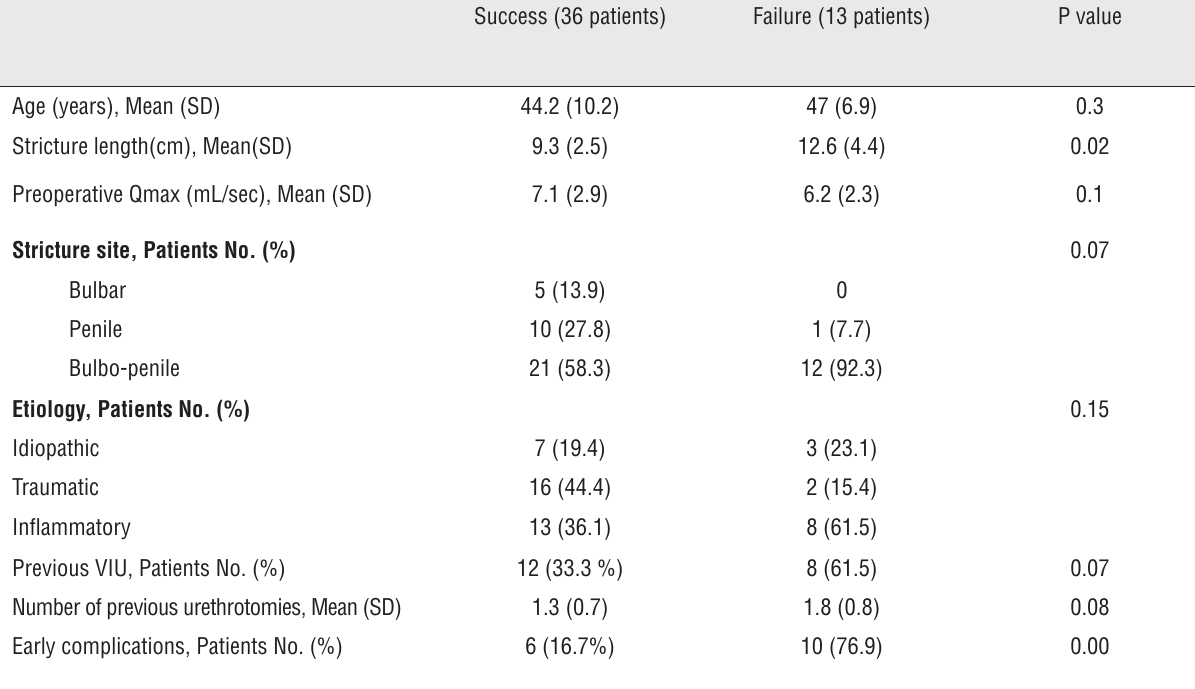
Table 3 - univariate analysis for predictors of